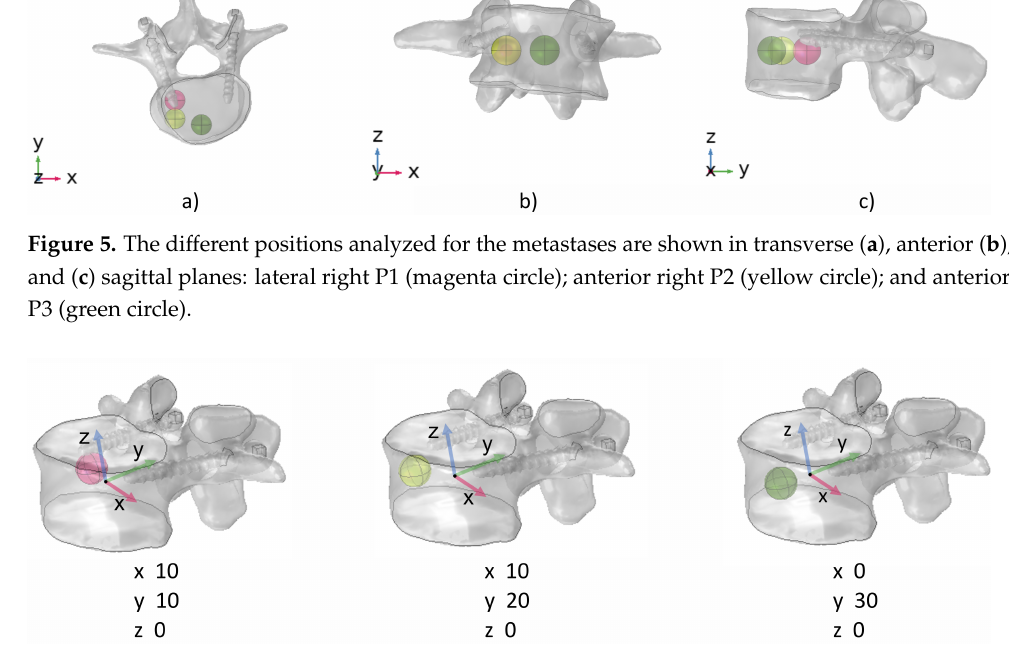
Figure 6. Coordinates of the lesion’s center (in mm) with respect to the center of the vertebral body for each position analyzed. The reference system is localized in the center of the vertebral body. From left to right: lateral right P1 (magenta circle); anterior right P2 (yellow circle); and anterior P3 (green